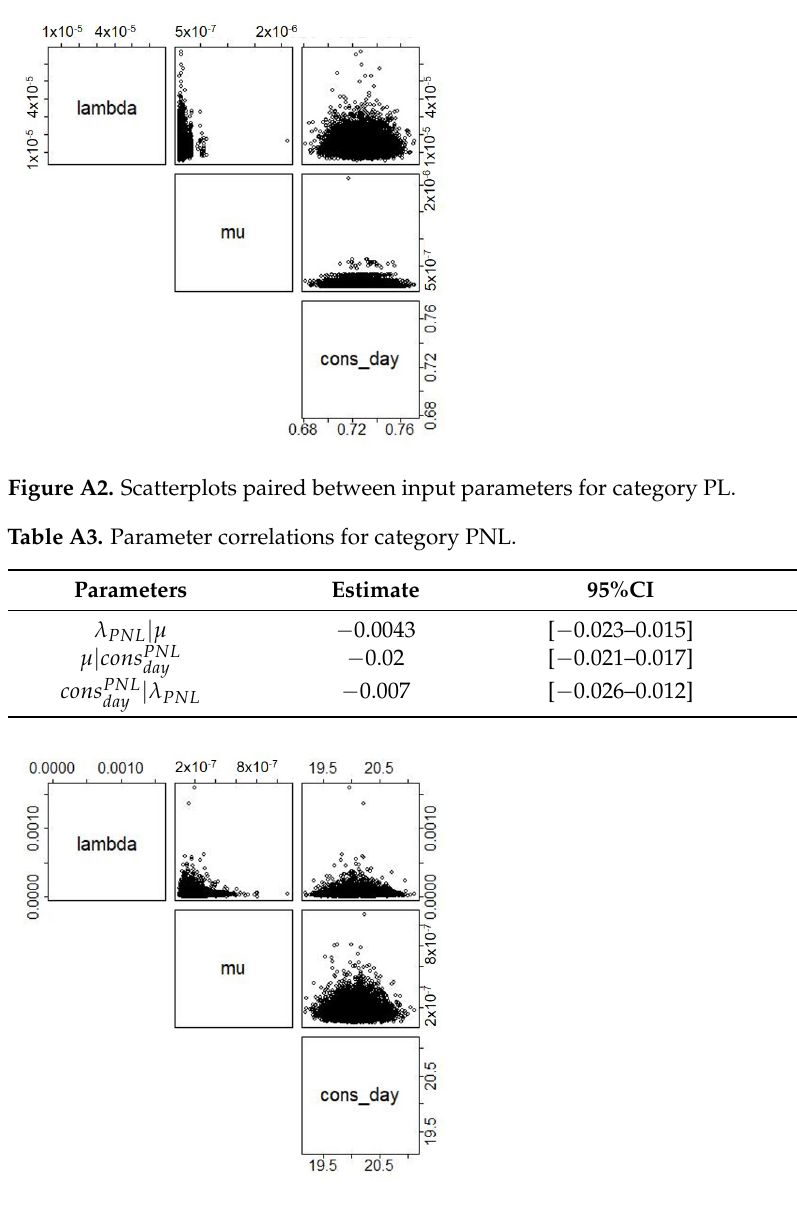
Figure A3. Scatterplots paired between input parameters for category PNL. Table A4. Parameter correlations for category